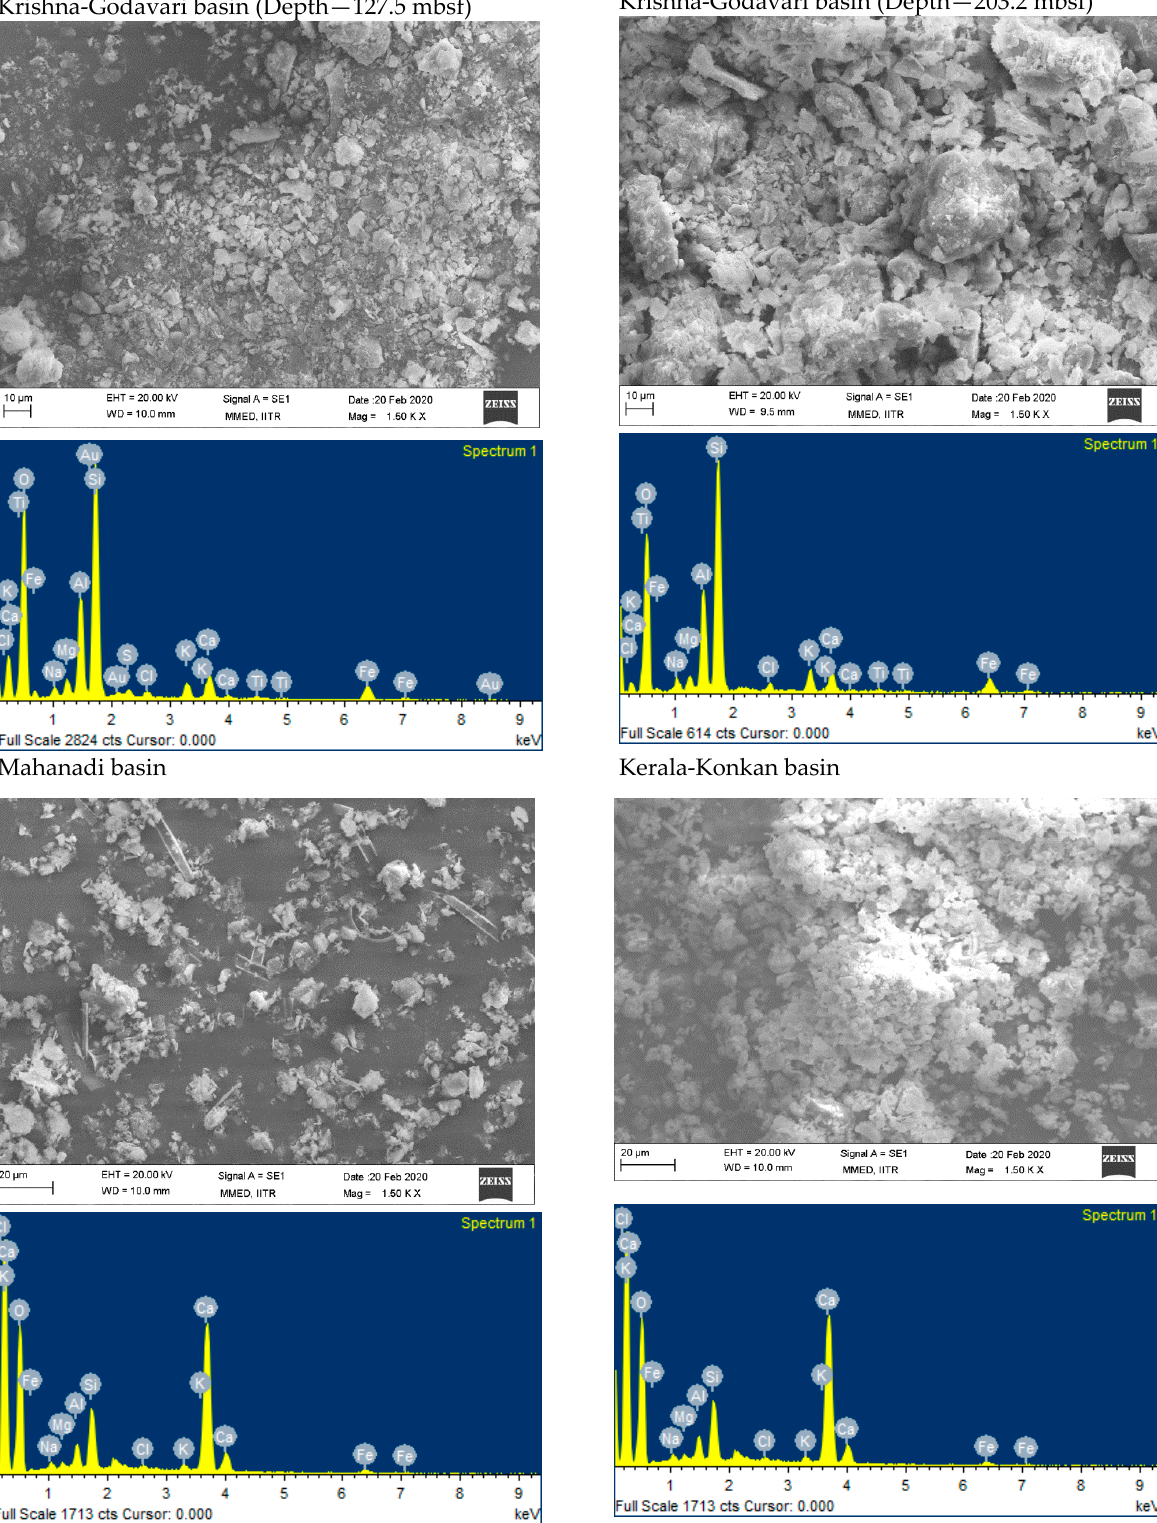
Figure 7. Analysis of SEM and EDS for hydrate-bearing sediment samples. Table 10. Elemental analysis of hydrate-bearing sediment samples.